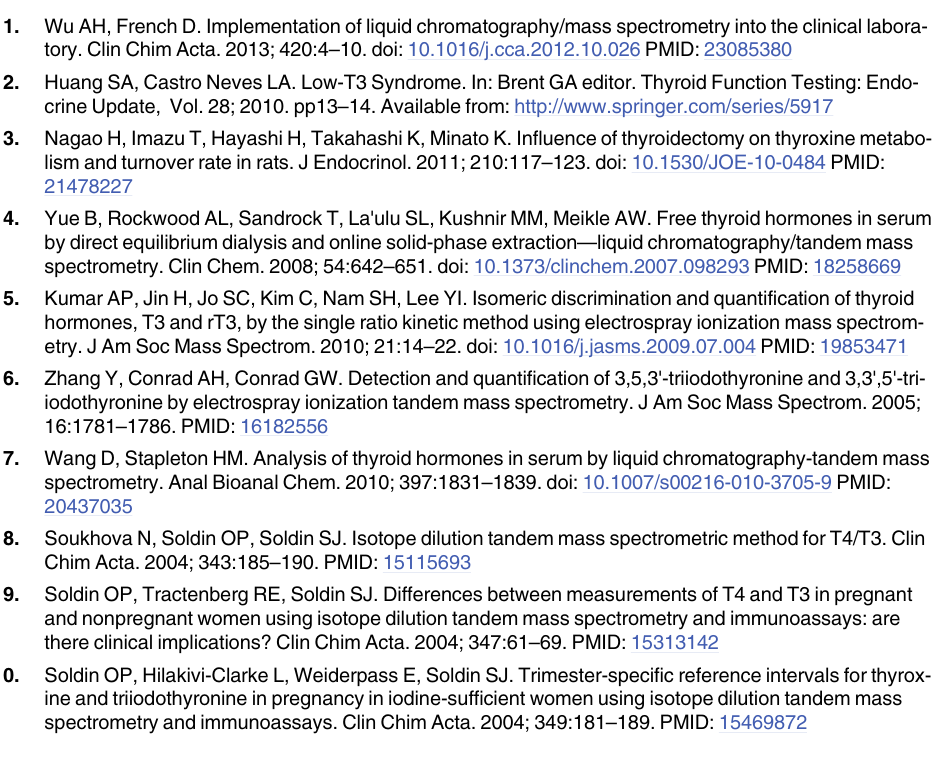
S1 Fig. Typical LC-MS/MS chromatograms of T4 (A), T3 (B), rT3 (C) and [ 2 H patient serum sample. The measured concentrations of T4, T3 and rT3 were 65.8, 1.00 and